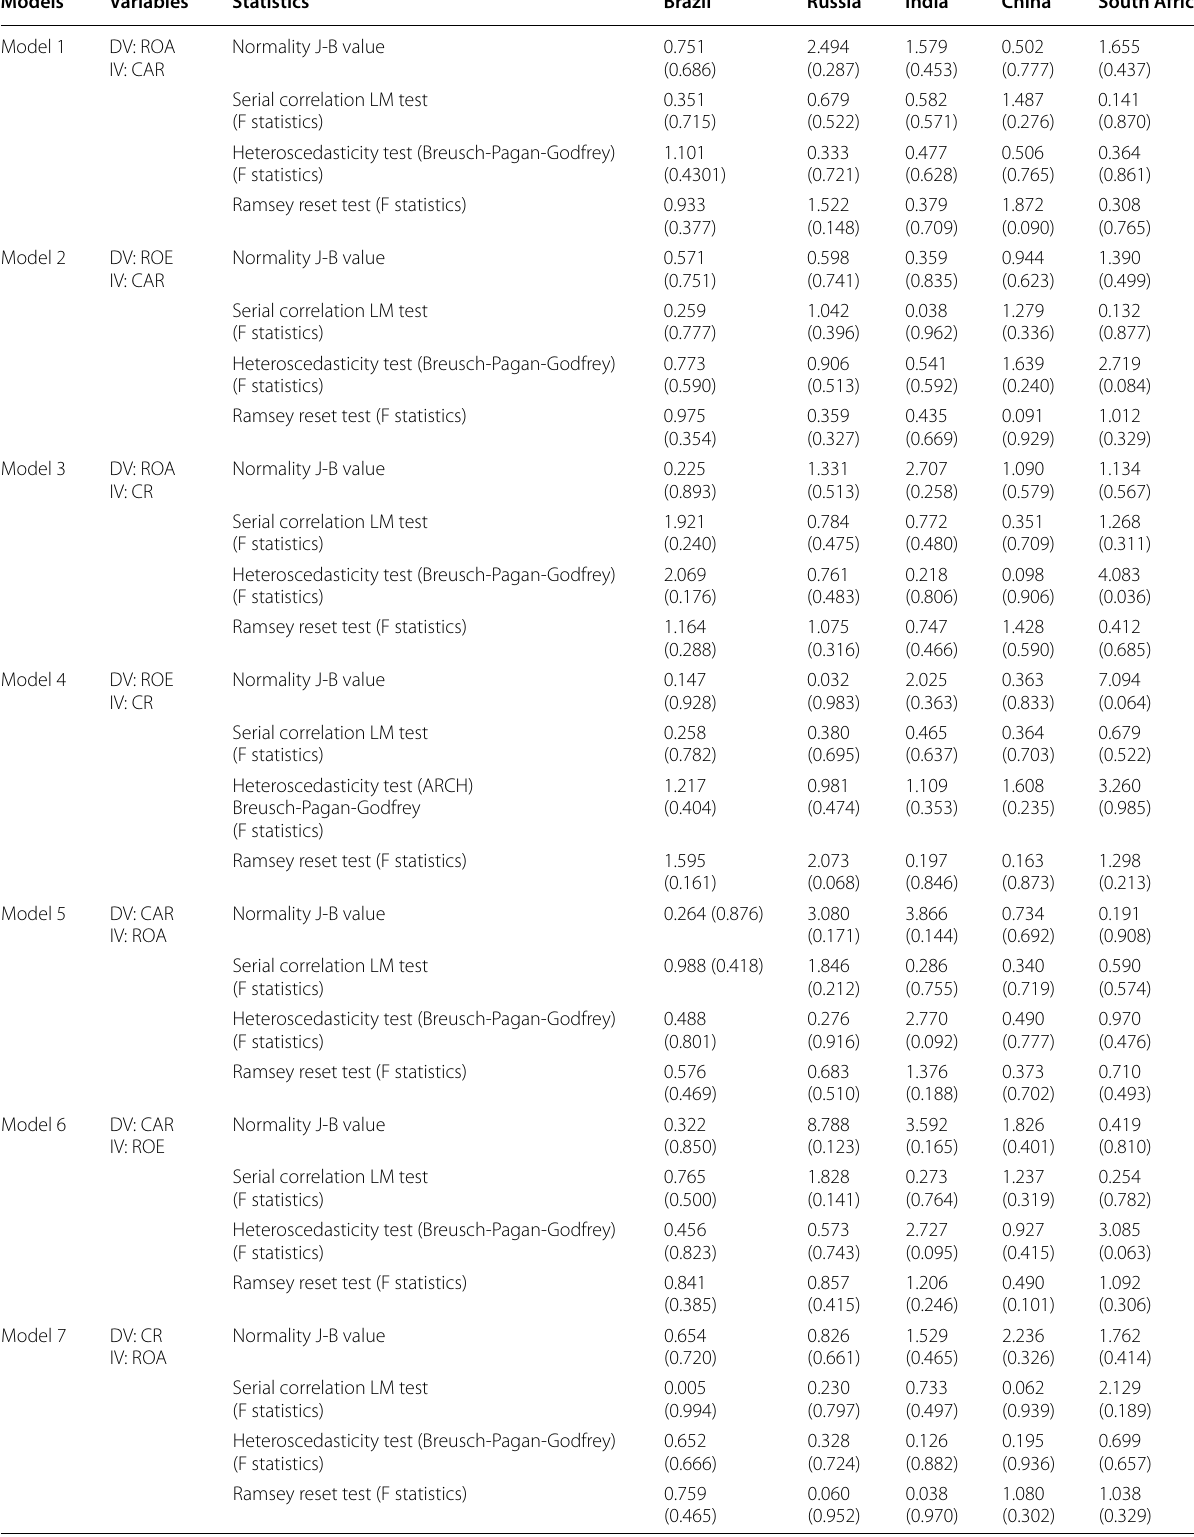
Table 4 ARDL Diagnostic Test. Source : Authors’ estimations using STATA